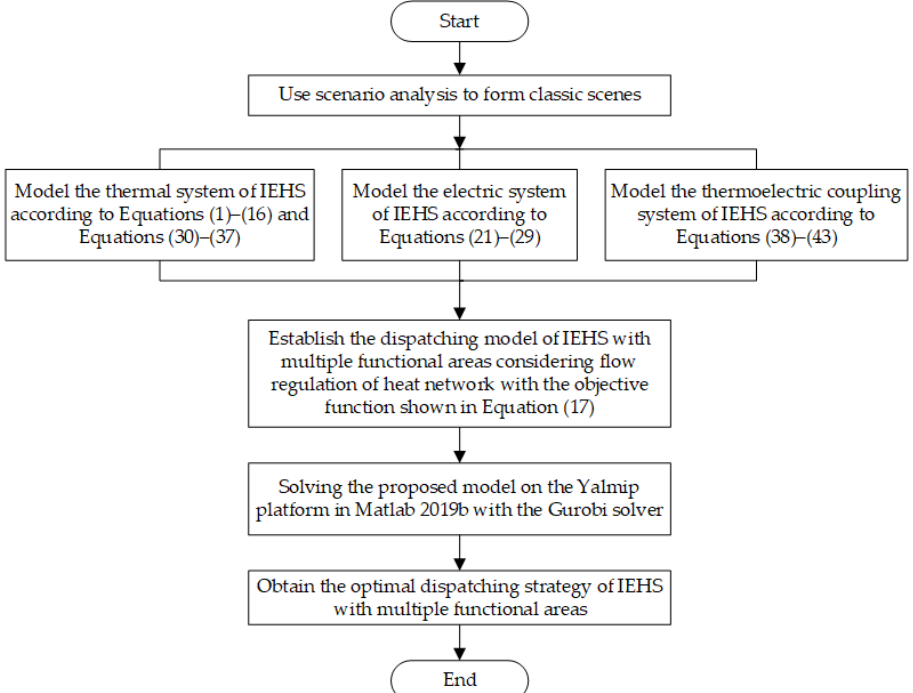
Figure 5. The process of the optimization algorithm.